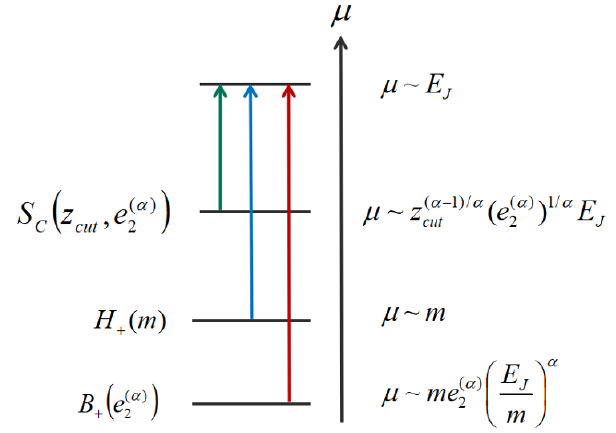
Figure 8 . Resummation path evolving ultracollinear, HQET matching, and collinear-soft functions from their natural scales to the common scale (cid:22) (cid:24) E J , where the hard function is